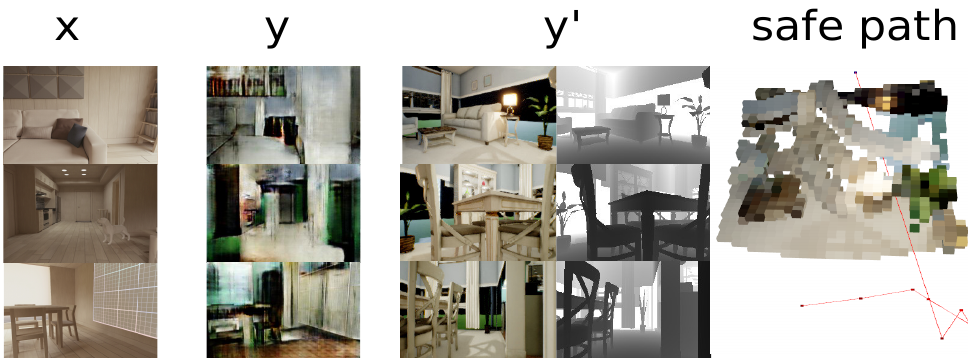
Figure 7. Change in domains to achieve a path in a known scenario. In the first stage (X), the sample from the unknown domain is translated to the known domain (Y). Subsequently, the samples from the known domain are approximated to generate the path